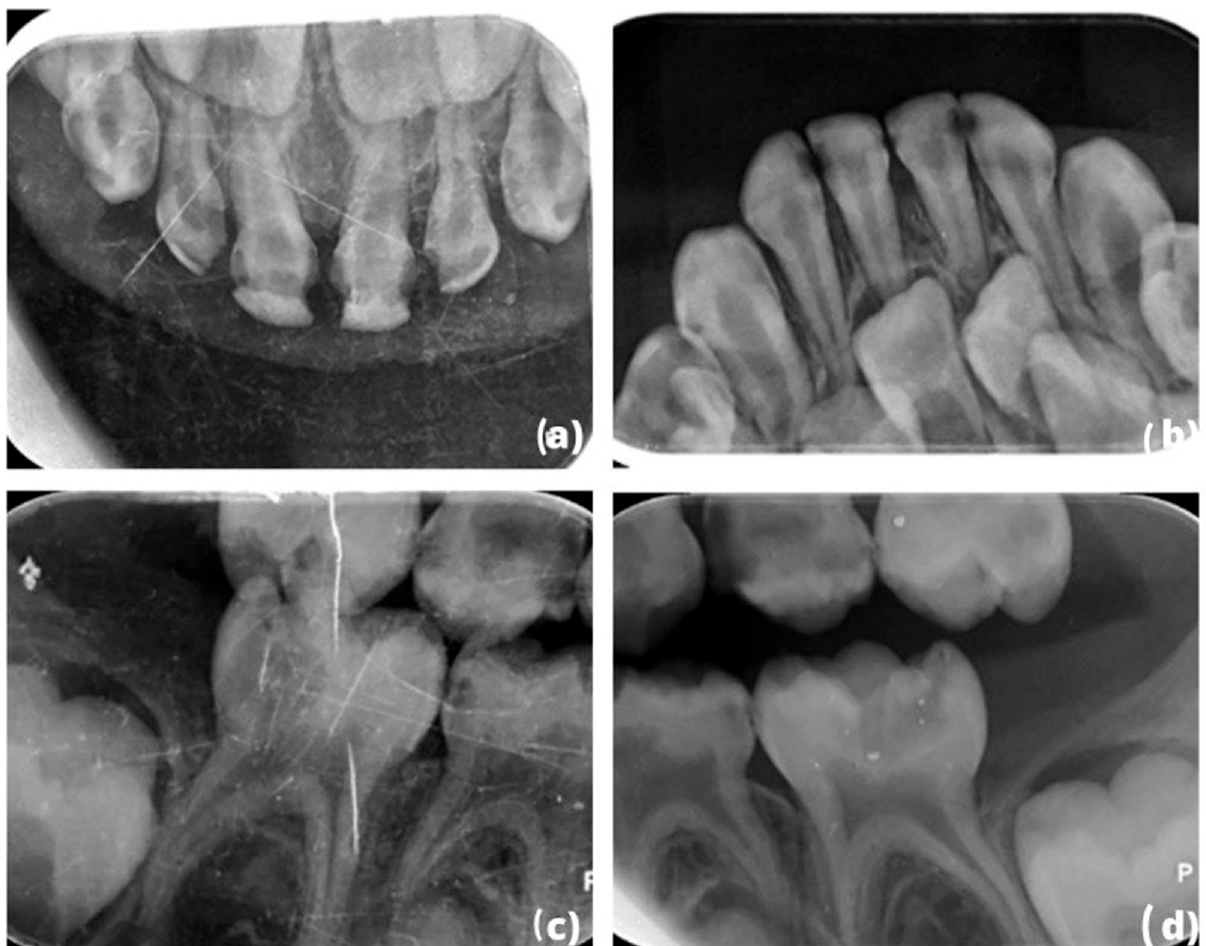
Figure 2. ( a – d ): Preoperative x-rays: ( a , b ) occlusal x-ray of the maxillary and mandibular situation and ( c , d ) bitewing of the right–left side.